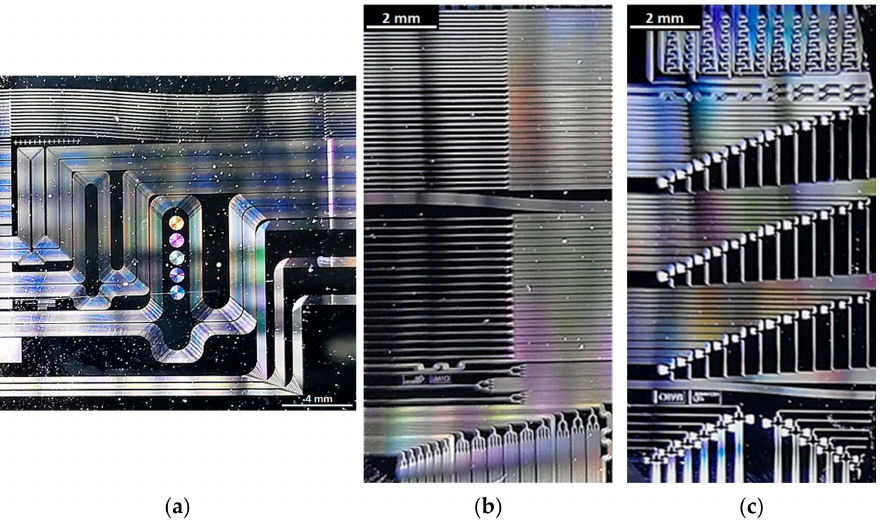
Figure 14. Optical micrographs of fabricated chips: ( a ) 1st Topography (from Layout 1); ( b ) 2nd Topography (from Layout 2); ( c ) 3rd Topography (from Layout 3).